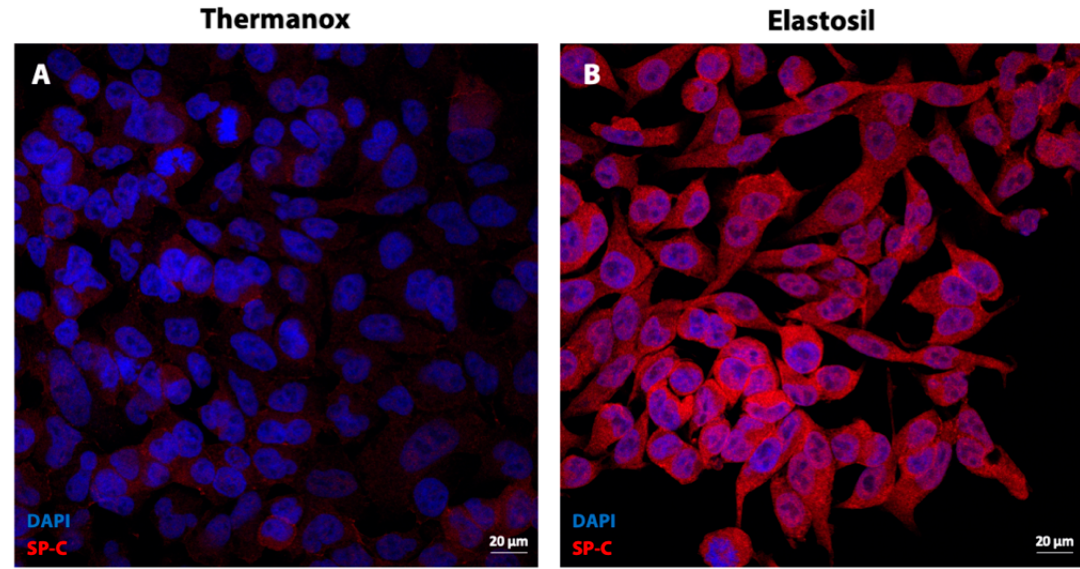
Figure 7. Immunofluorescence images of A549 cells stained for Prosurfactant Protein C (red) and nuclei (blue) cultured on Thermanox™ Coverslips ( A ) and on Elastosil ® Film ( B ) after 72 h of culture. Magnification 40 ×